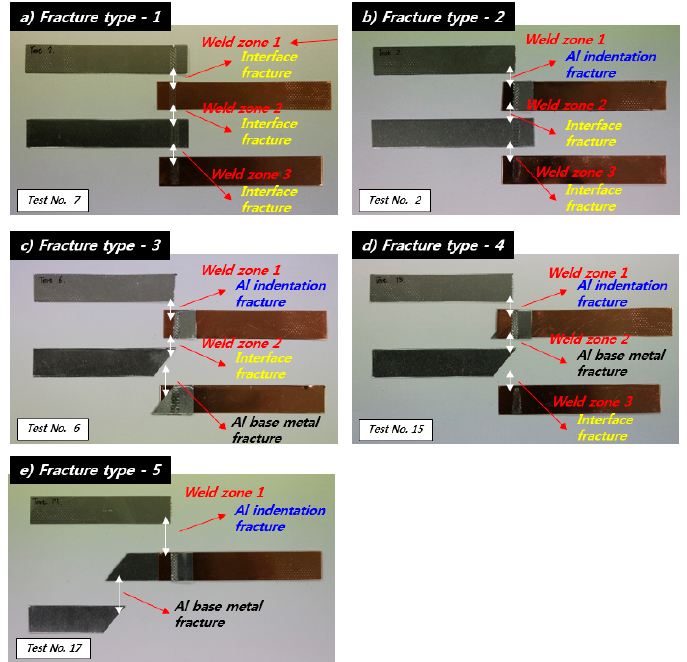
Figure 8. Five kinds of fracture types in a one-step shear strength test. ( a ) Interface fracture at all weld zones, ( b ) Combination fracture of Al indentation and interface, ( c , d ) Combination fracture of Al indentation, interface and Al base metal, ( e ) Combination fracture of Al indentation and Al base metal.